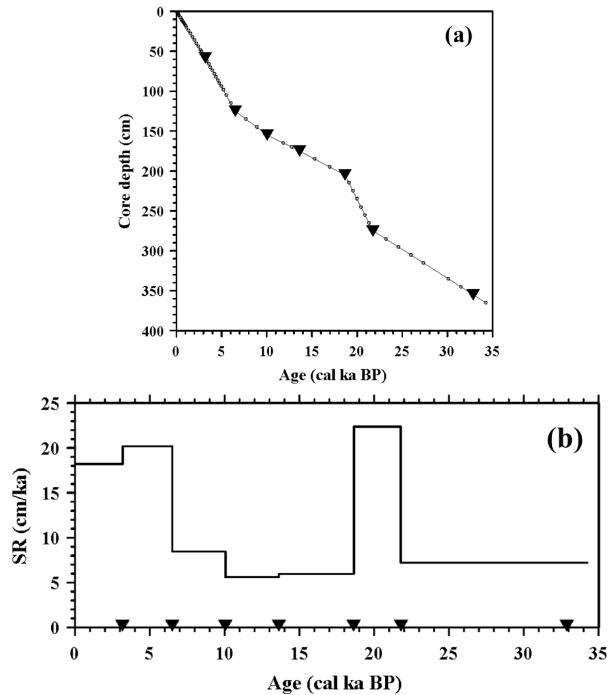
Figure 2. (a) Plot of calendar age against depth; (b) Linear sedi- mentation rate (indicates the 14 C age controlling points).